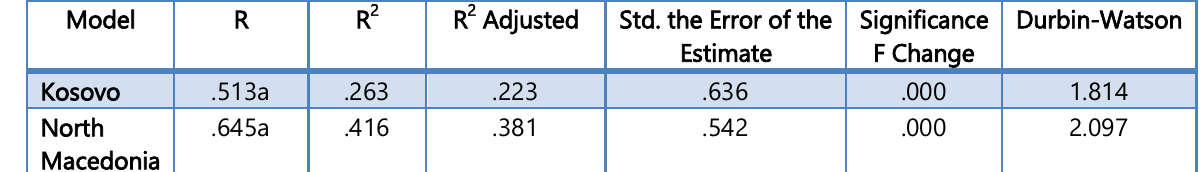
Table 2: Model summary (Source: Authors‟ depiction) Model R R 2 R 2 Adjusted Std. the Error of the Kosovo .513a .263 .223 .636 .000 1.814 North .645a .416 .381 .542 Macedonia